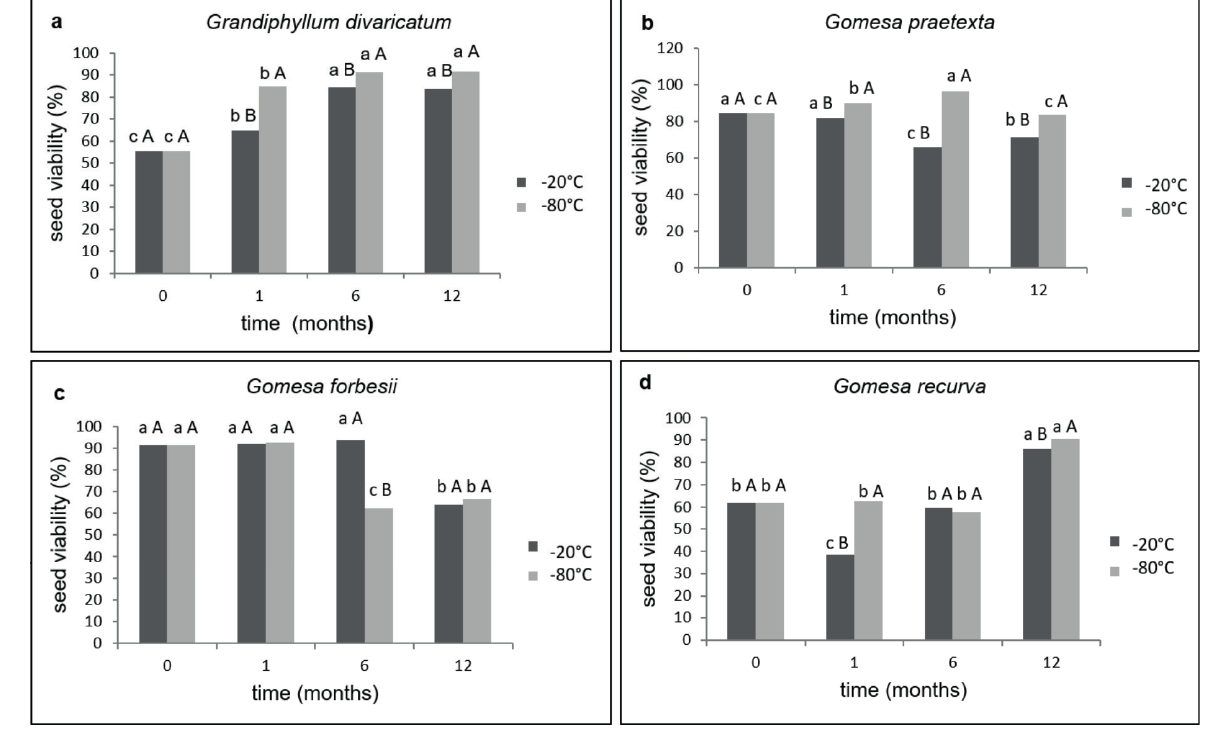
Figure 2 - Seed viability evaluated by tetrazolium test of: a- Grandiphyllum divaricatum , b- Gomesa praetexta, c- Gomesa forbesii and d- Gomesa recurva stored at -20 and -80°C for 0, 1, 6 or 12 months. Lowercase letters indicate diff erences between storage times in the same temperature and uppercase letters indicate diff erences between storage temperatures in the same storage time, according to Tukey test (p